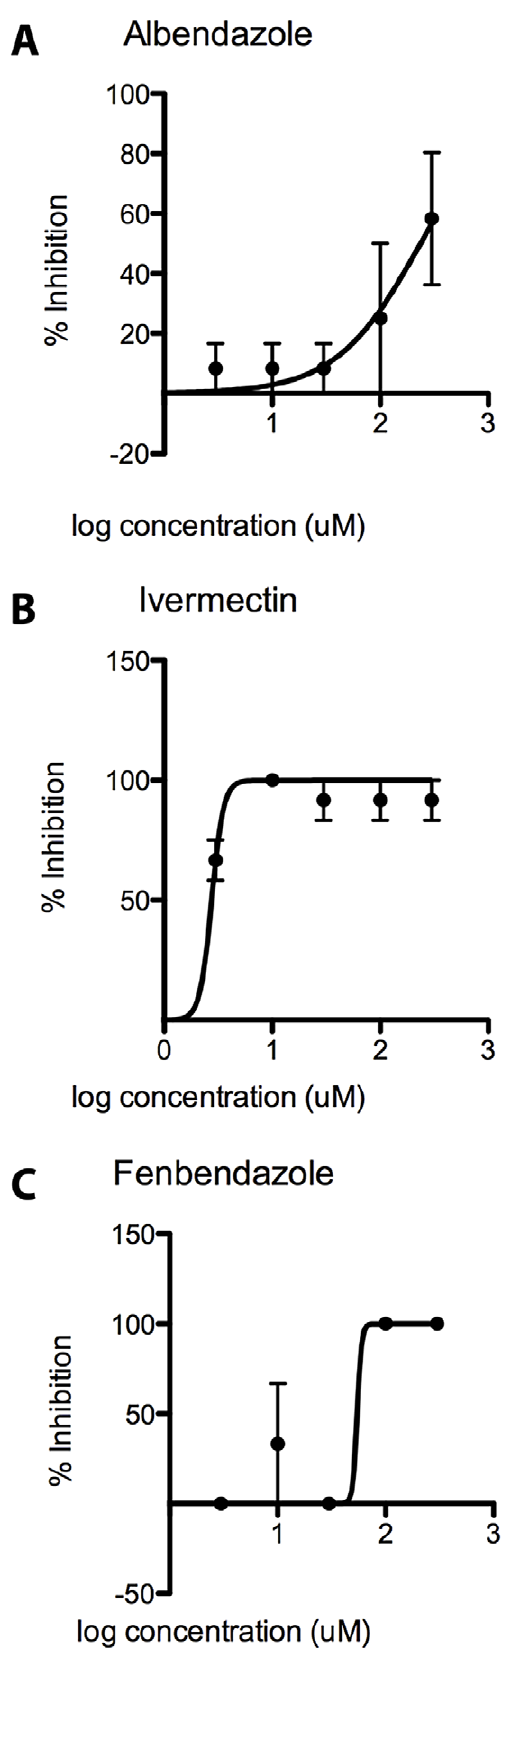
Figure 3. Dose-response curves of anthelmintic compounds used for validation. IC 50 s of (A) albendazole ( 236 : 2 m M ), (B) ivermectin ( 2 : 7 m M ) and (C) fenbendazole ( 54 : 5 m M ) determined using the proposed method with compounds at concentrations of 300 m M , 100 m M , 30 m M , 10 m M , 3 m M and 0 m M